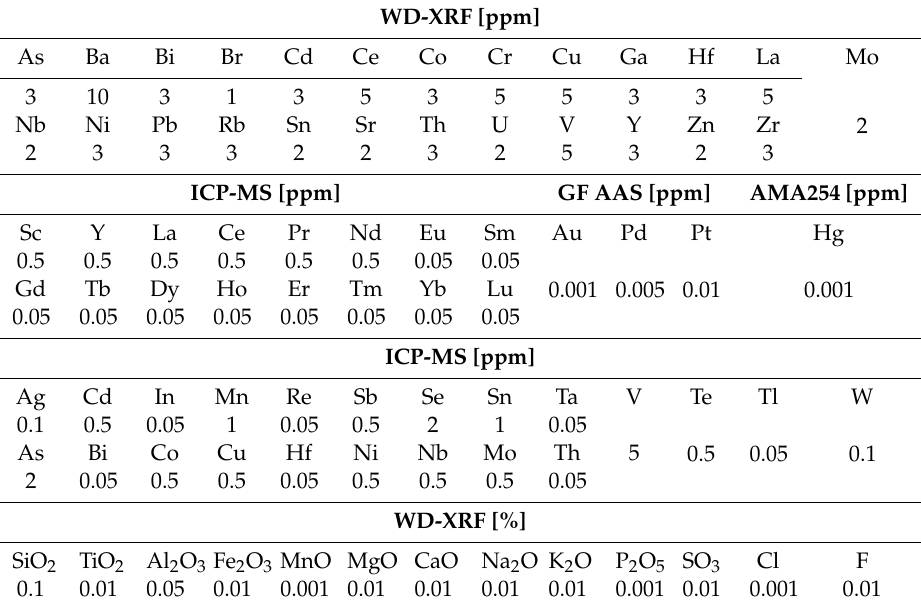
Table 1. The minimum detection limits of element measurements by applied